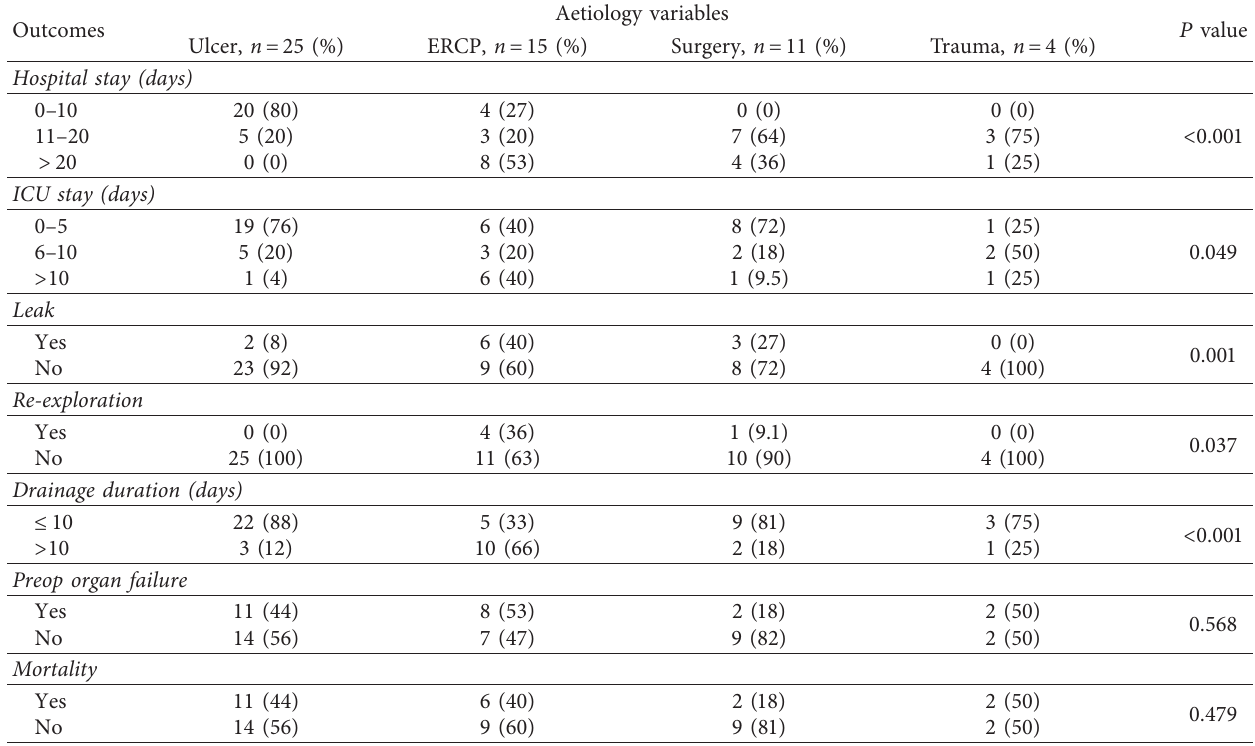
Table 2: Association of aetiological factors with outcome